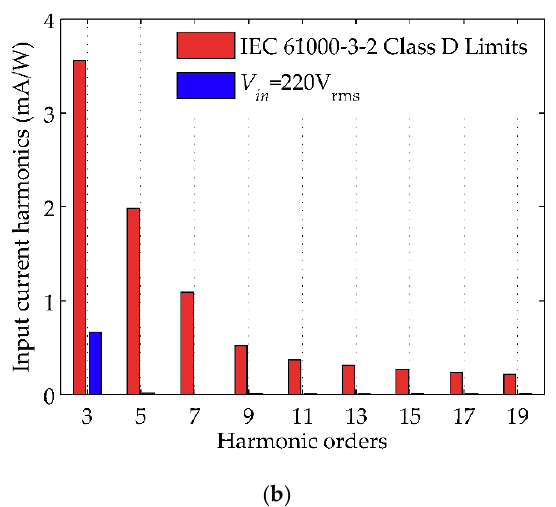
Figure 13. The simulated input current harmonics of the proposed bridgeless high step-up voltage gain PFC converter compared with the IEC 61000-3-2 class D limits: ( a ) v in = 110 V rms ; ( b ) v in = 220 V rms .